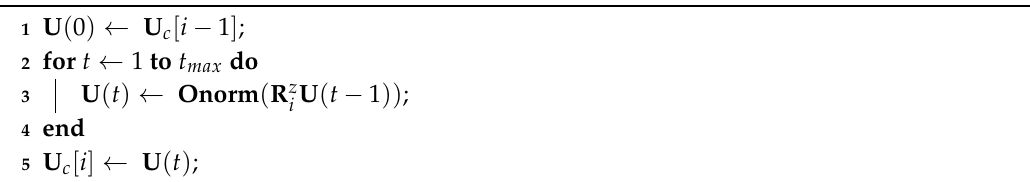
Algorithm 1: Orthogonal Iteration updating process for the i th